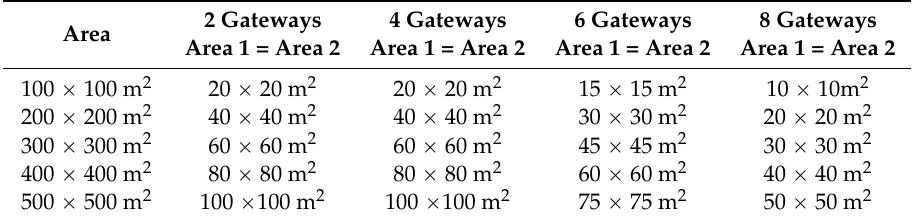
Table 2. Area division parameters.